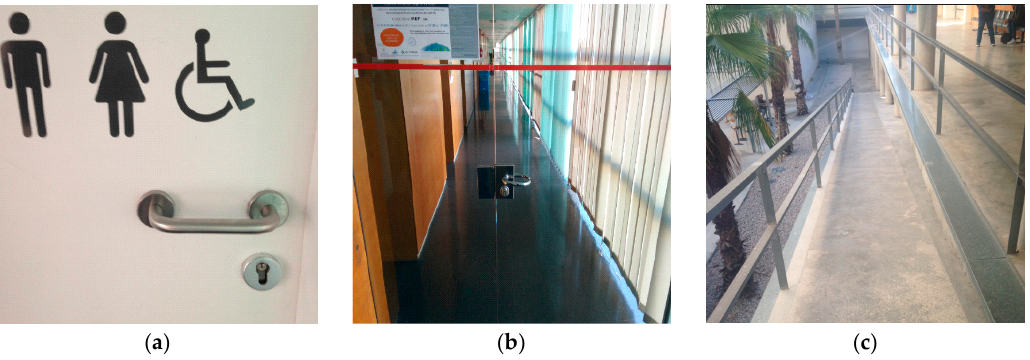
Figure 15. Different KAIs obtained in the validation process in Politécnica IV building. ( a ) KAIs 234 & 237; ( b ) KAI 235; ( c ) KAI 239.